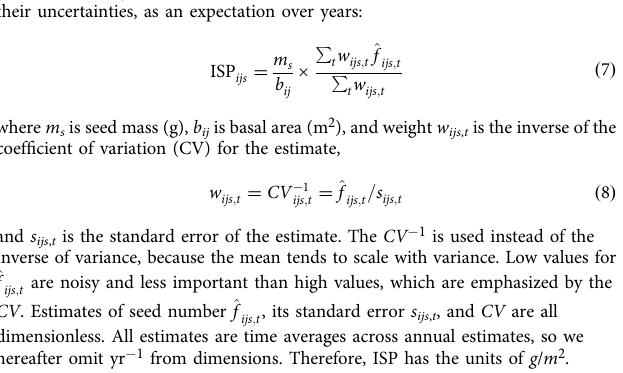
Fecundity modeling and inference). Data coverage by sites is included in table S2, with sample sizes (tree-years) summarized by species provided in the fi le supplementSampleSize.csv .